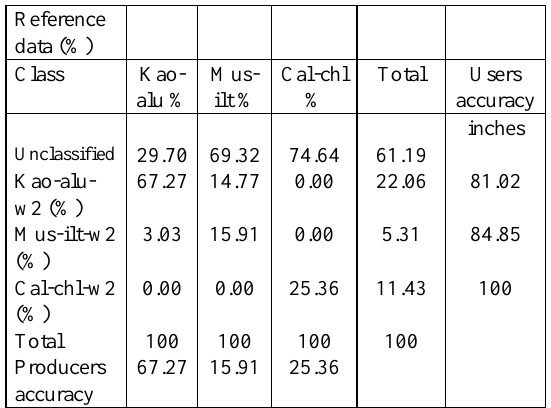
Table 4. Error matrix for SAM at 0.02 angle (image spectra) Overall Accuracy = 33.8%; Kappa Coefficient = 0.24